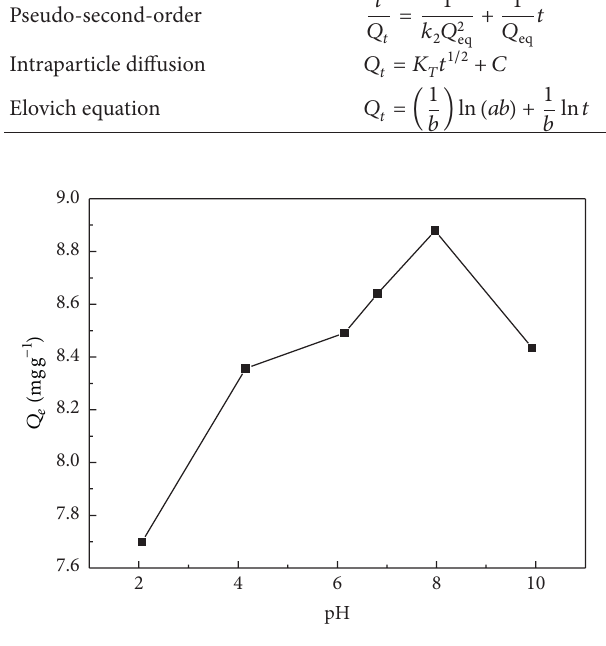
Figure 9: The influence of pH on the adsorption capacity of AC2 for methylene blue with concentration of 12.016 mg L −1 at 25 ∘ C.